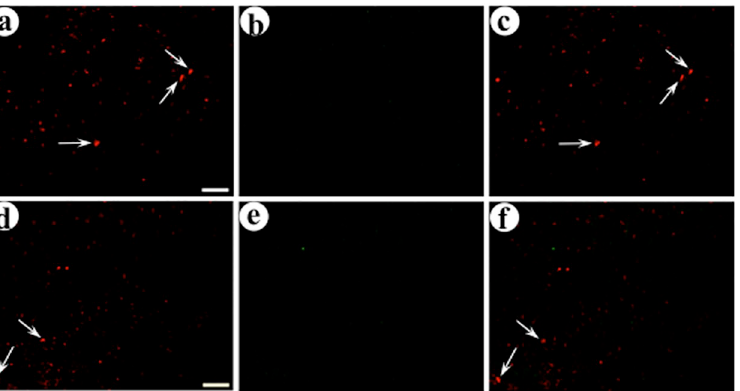
Fig 5. Recombinant proteins in the middle layers of POR cortex after injection of a presynaptic vector, pGADdcv- pomc/anti-GABA A ß2or3-LtoH/his-tag, into the middle layers of POR cortex followed by coinjection of the two postsynaptic vectors into the upper layers of POR cortex. The experimental design and immunofluorescent costaining were as above. (A-C) Expression from this presynaptic vector and the targeted postsynaptic vector; (A) His tag-IR, (B) GFP-IR, and (C) merge. Arrows, cell bodies expressing the synthetic peptide neurotransmitter from the presynaptic vector. (D-F) Costaining for this presynaptic vector and the control, untargeted postsynaptic vector; (D) His tag-IR, (E) flag-IR, and (F) merge. Scale bar: 50 μ m.